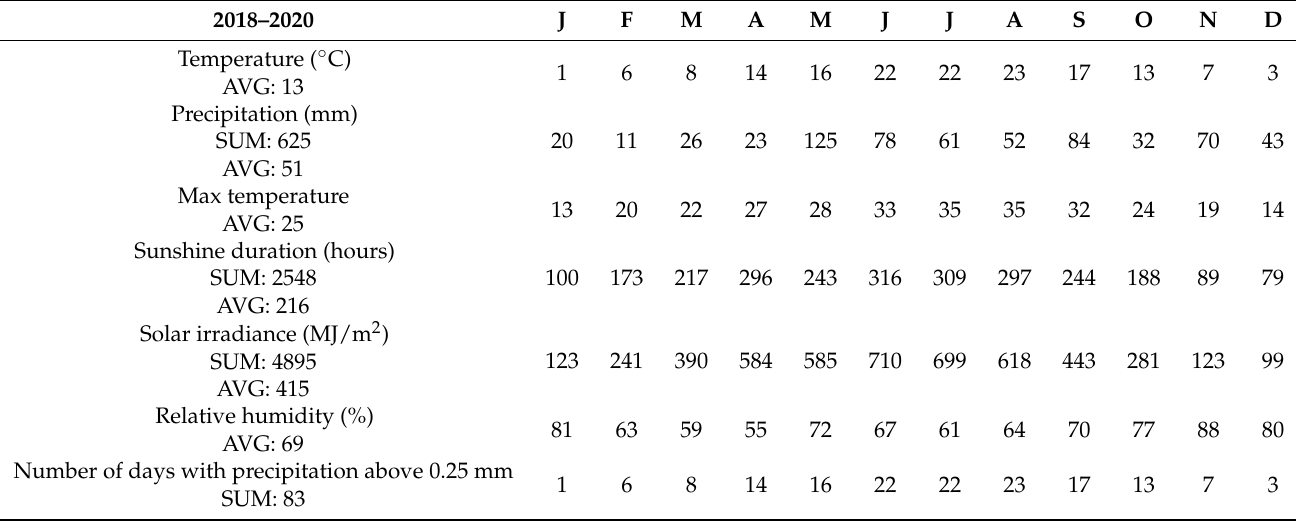
Table 5. Monthly breakdown of average weather